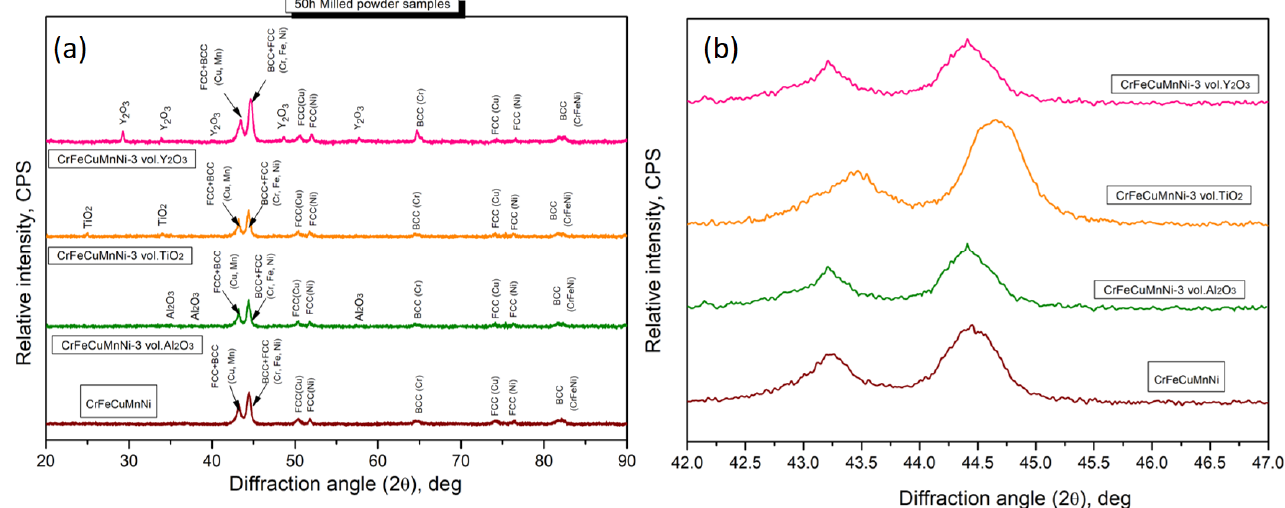
Figure 7 . X-ray diffraction peak profile of ( a ) 50 h milled oxide-dispersed strengthened high-entropy composites (ODS-HECs) of CrFeCuMnNi, CrFeCuMnNi-3 vol.% Al 2 O 3 , CrFeCuMnNi-3 vol.% TiO 2 , and CrFeCuMnNi-3 vol.% Y 2 O 3 , and ( b ) magnified view of ( a ) showing peak shift observed in major phase.